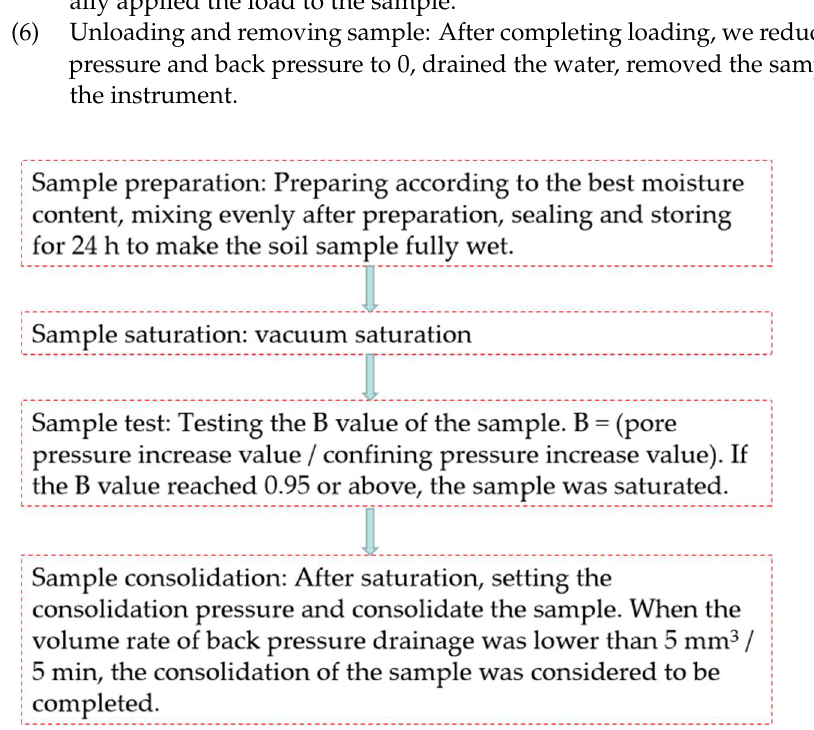
Figure 3. The entire research process.